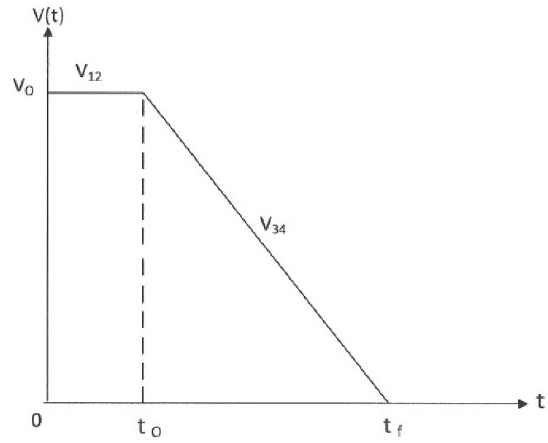
Figure 4: A first approximation to the velocity profile of Fig. 3 for modelling purposes. The proposed framework permits other ap- proximations to be included in the future.